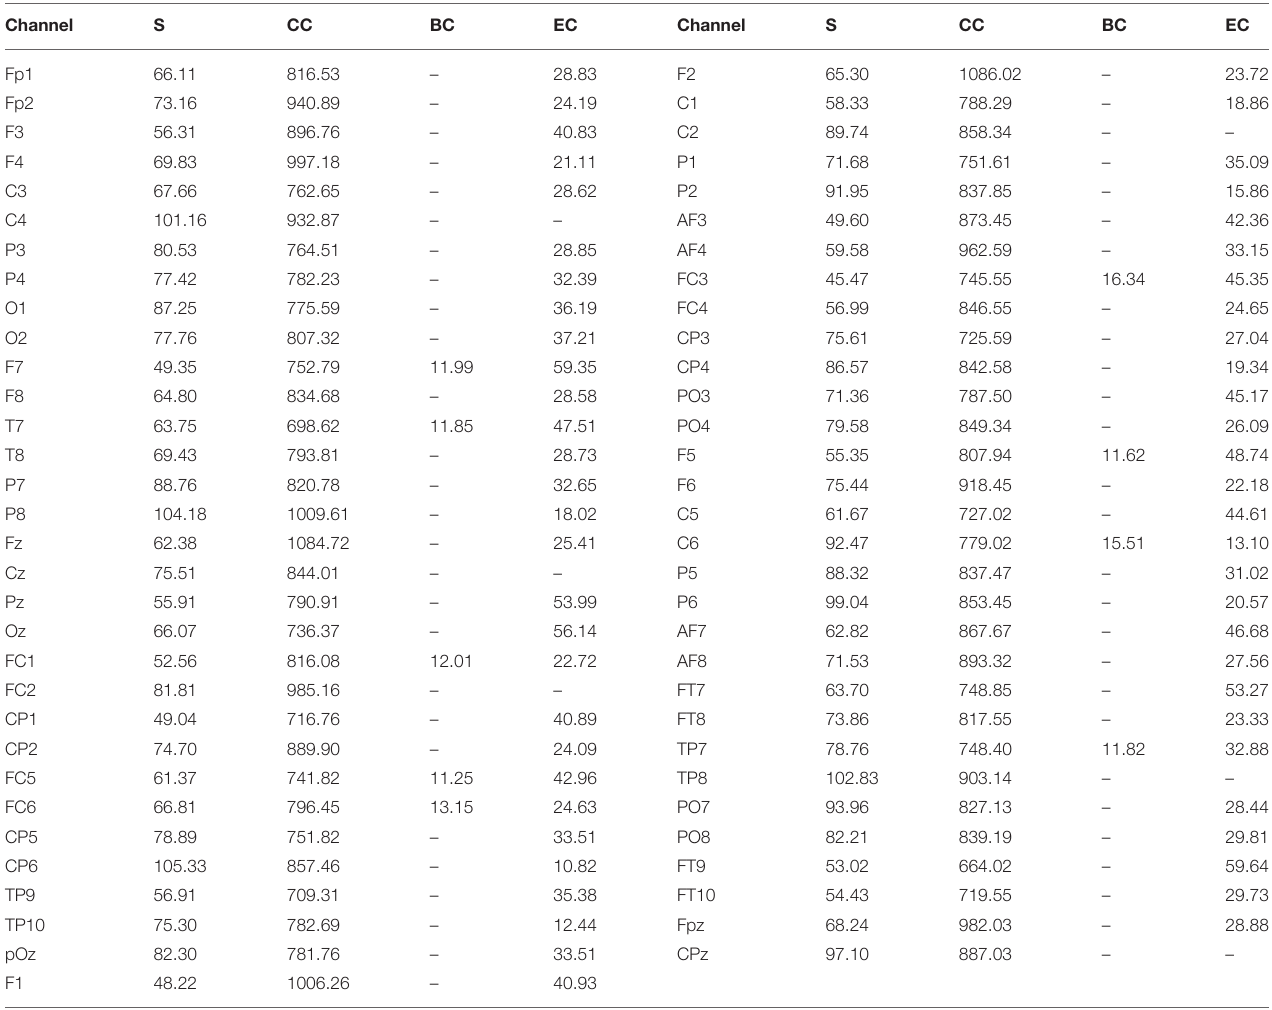
TABLE 2 | F -values for local graph metrics showing significant differences ( p < 0.00002, ANOVA test, Bonferroni corrected) between before, mid, and far EEG epochs.